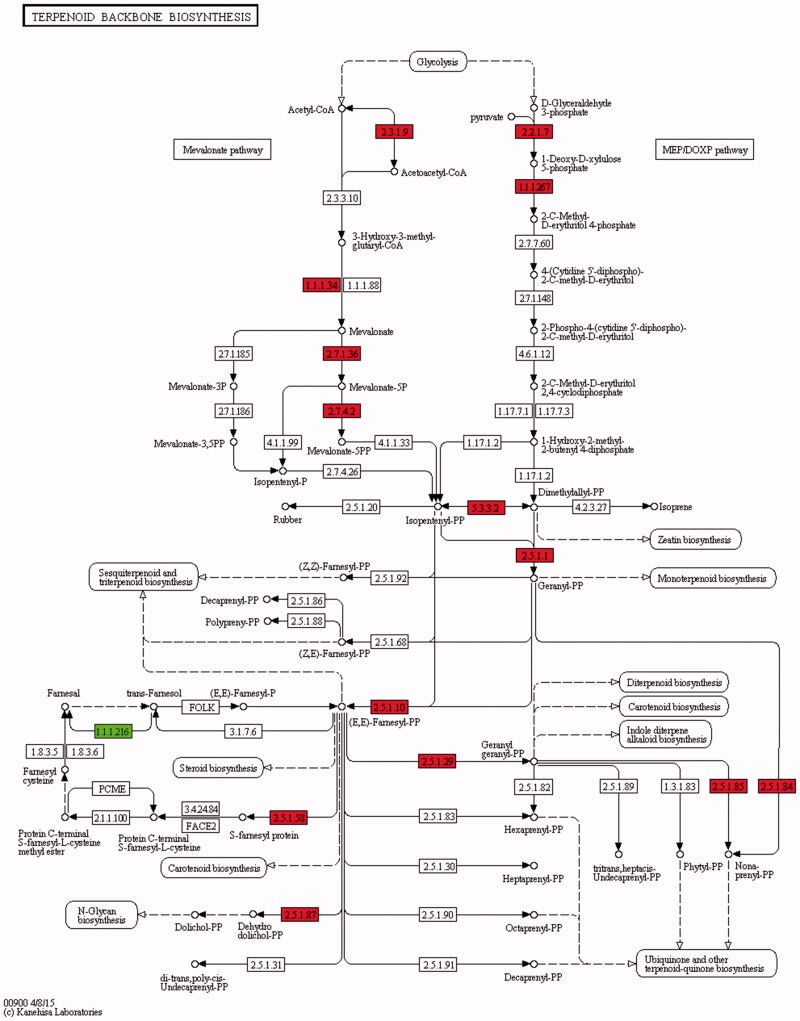
Terpenoid backbone biosynthesis. The number in the box represents the number of the enzyme (EC number). The red and green boxes represent the up-regulated and down-regulated genes, respectively. The differentially expressed enzyme genes in Figure 4 correspond to the genes in Table 5 (up-regulated genes: AACT, HMGR, MK, PMK, DXS, DXR, IDI, GPPS, FDPS, GGPPS, SPS, SDS, DHDDS, RER2, SRT1, FNTB; down-regulated genes: FLDH).